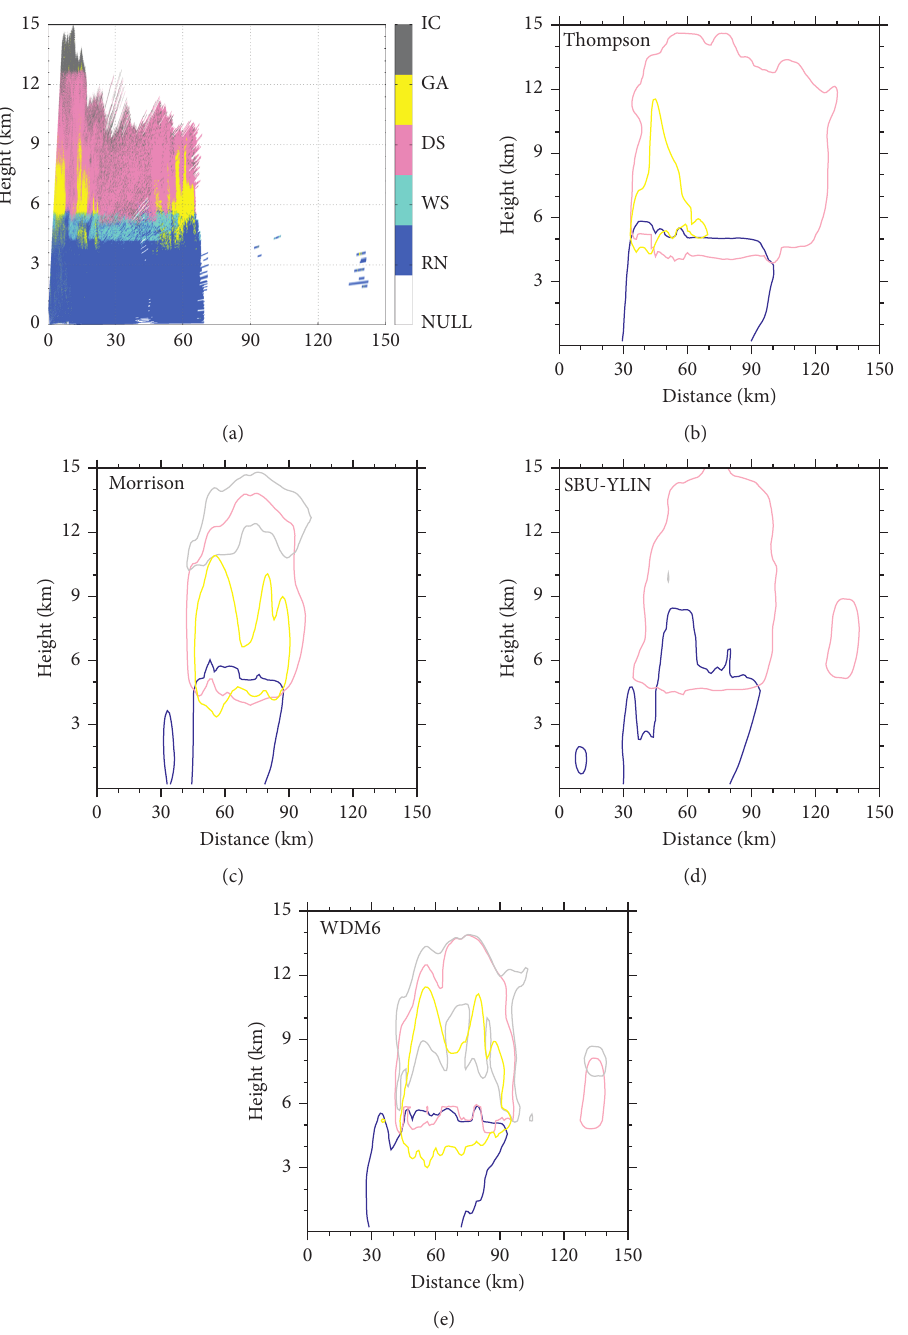
Figure 11: Vertical cross section of hydrometeor categories derived from C-POL along 284.0 ° azimuth at 0925 LT on 30 June 2018 and simulations. HC categories are defined as IC � ice crystals, GA � graupel, DS � dry snow, WS � wet snow, and RN � rain. For the simulations, the blue curve represents the area where the rain mixing ratio is positive, yellow line indicates graupel distribution, pink line represents snow distribution, and grey line represents ice